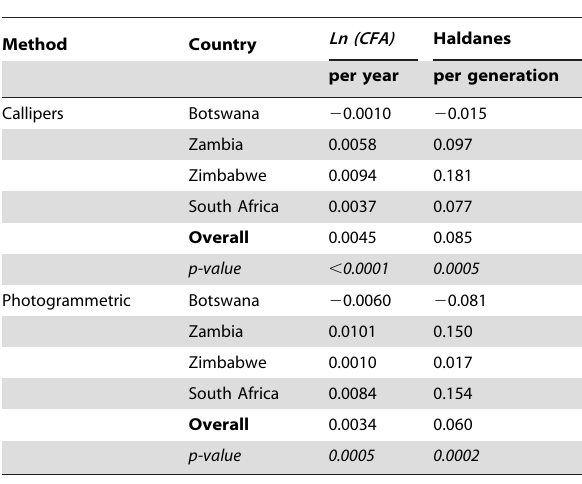
Table 2. Rate of change per year in cranial asymmetry measured using composite fluctuating asymmetry ln (CFA) with respect to time, and Haldanes with respect to generations.